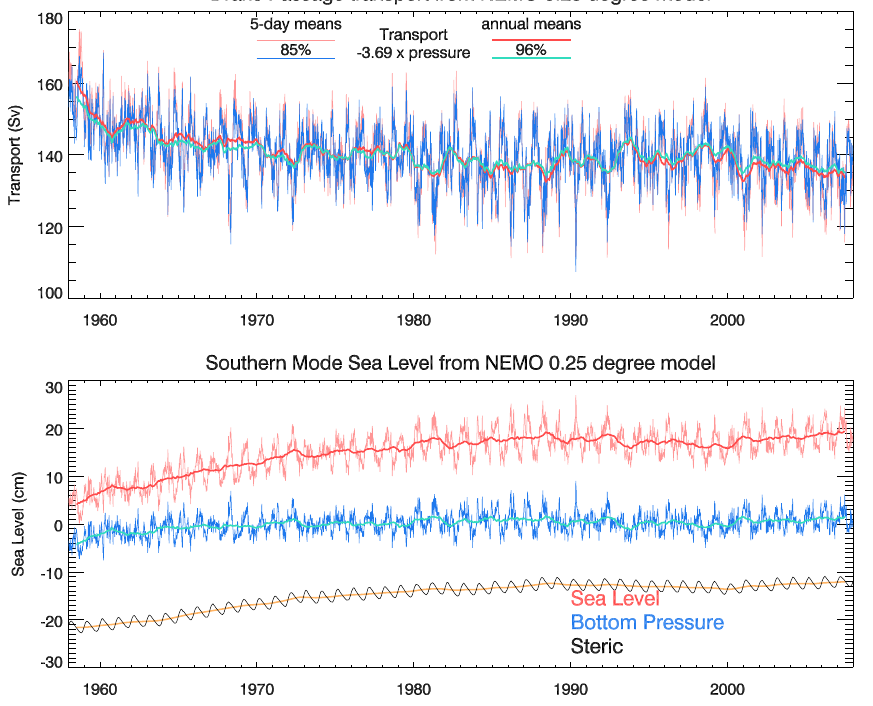
Fig. 3. Time series from the 1 / 4 ◦ model. Top: flow through Drake Passage before (pink) and after (red) applying a running 12-month smoother, and − 3 . 69Sv mbar − 1 × depth-averaged southern boundary pressure anomaly (blue and cyan), with a vertical offset applied to match. Numbers give the percentage of transport variance explained by the corresponding scaled pressure time series. Bottom: the pressure time series used to plot the upper panel (blue and cyan), converted to equivalent sea level units, together with the analogous sea level time series (pink and red), and the difference sea level − bottom pressure (black and orange). Note that the curves are shown with trend, annual, and semiannual cycles included, although these are removed when calculating